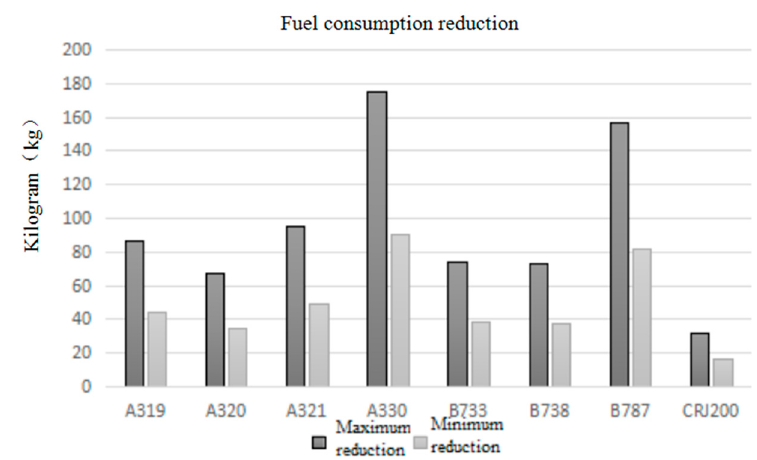
Figure 8. The fuel consumption reduction graph.